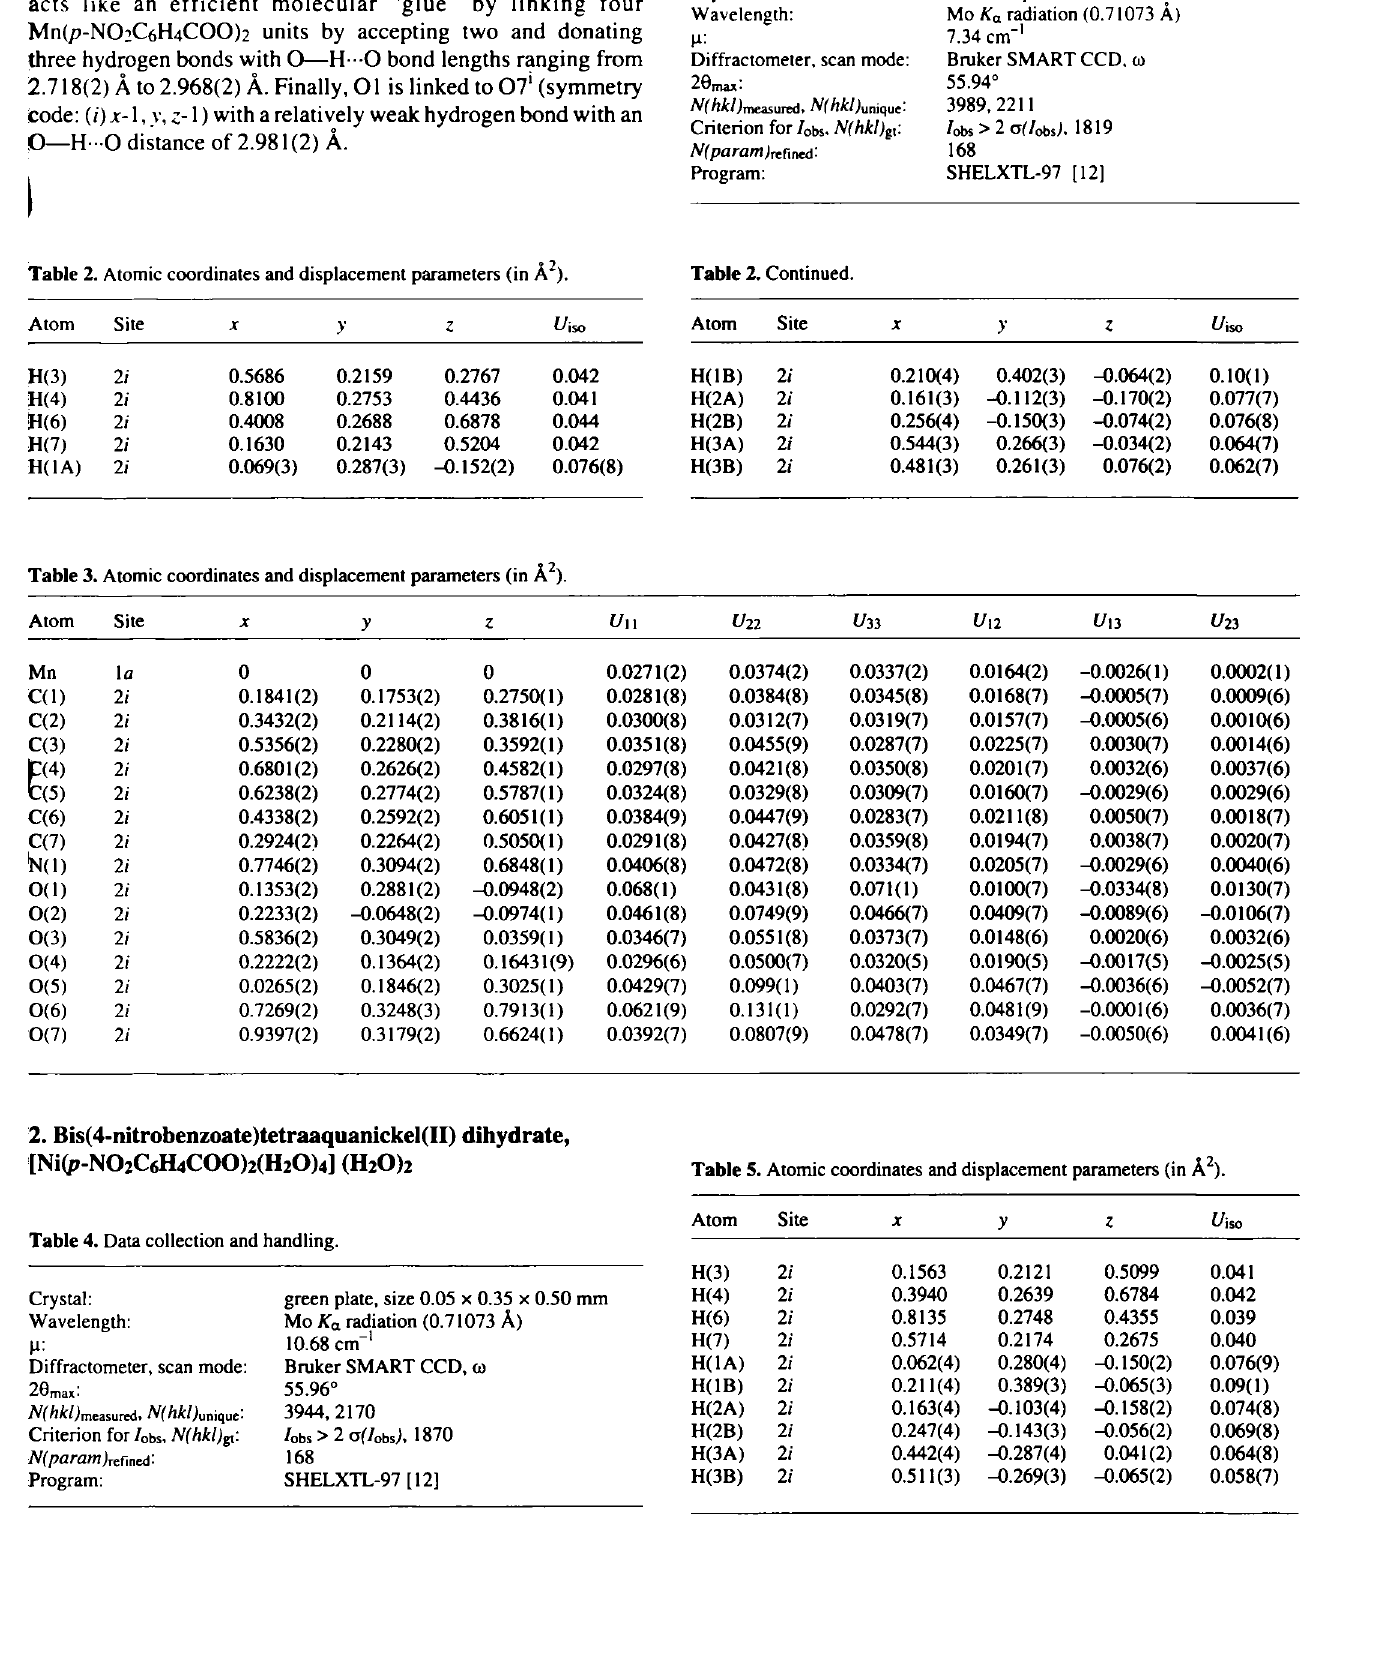
Table 2. Atomic coordinates and displacement parameters (in A 2 ).